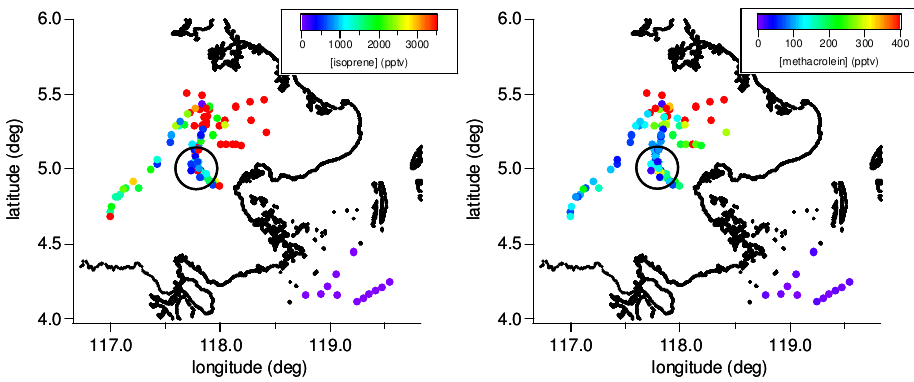
Figure 8. Regional variations in isoprene and methacrolein mixing ratios across Borneo (black open circle highlights the Danum Valley conservation area), for all samples collected on board the aircraft, below 500 ft. (VOC analysis was carried out by GC-FID analysis of whole air samples).